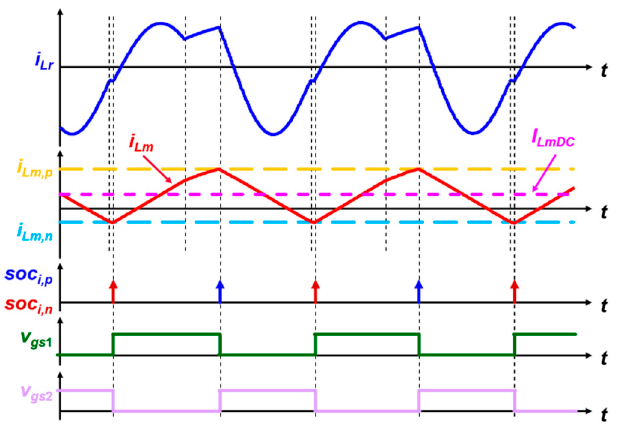
Figure 8. Magnetizing current sampling timing, where i Lm,p ( i Lm,n ) is sampled at the timing of v gs 1 ( v gs 2 ) from high to low.